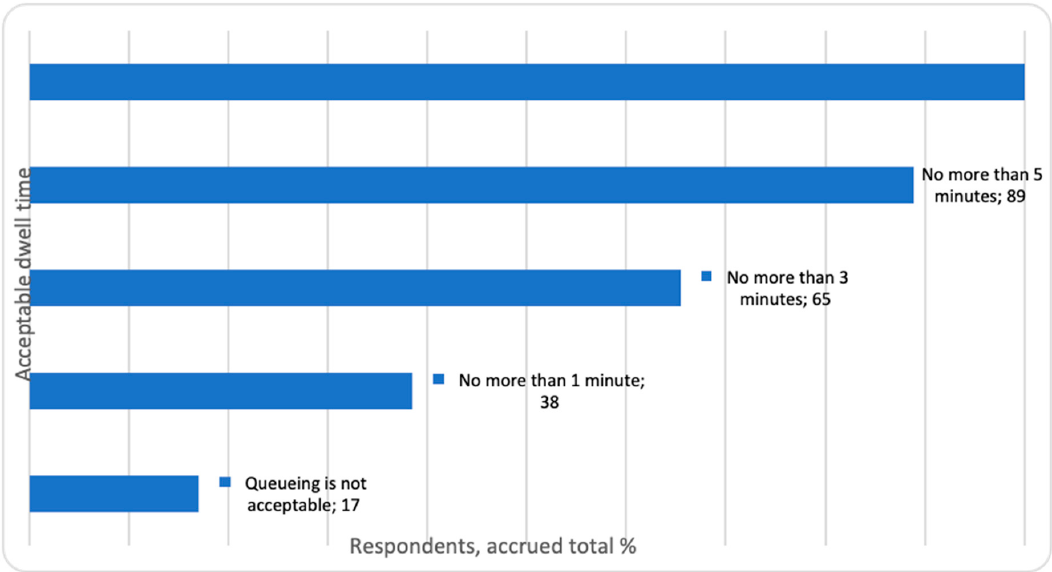
Figure 7. Acceptable dwell time at the station entrance/exit as an accrued total.